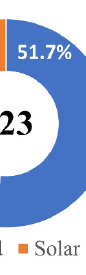
Table 7. Most Cited Papers (LCOE).